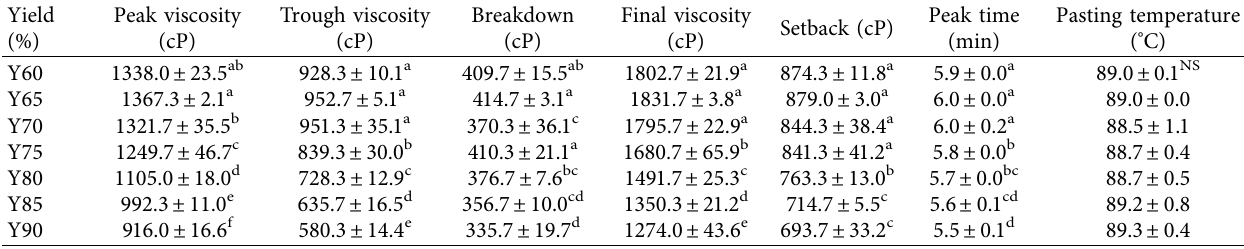
Table 5: Pasting properties by a rapid visco-analyzer of wheat flour (var. Jokyoung) according to flour yield. Yield